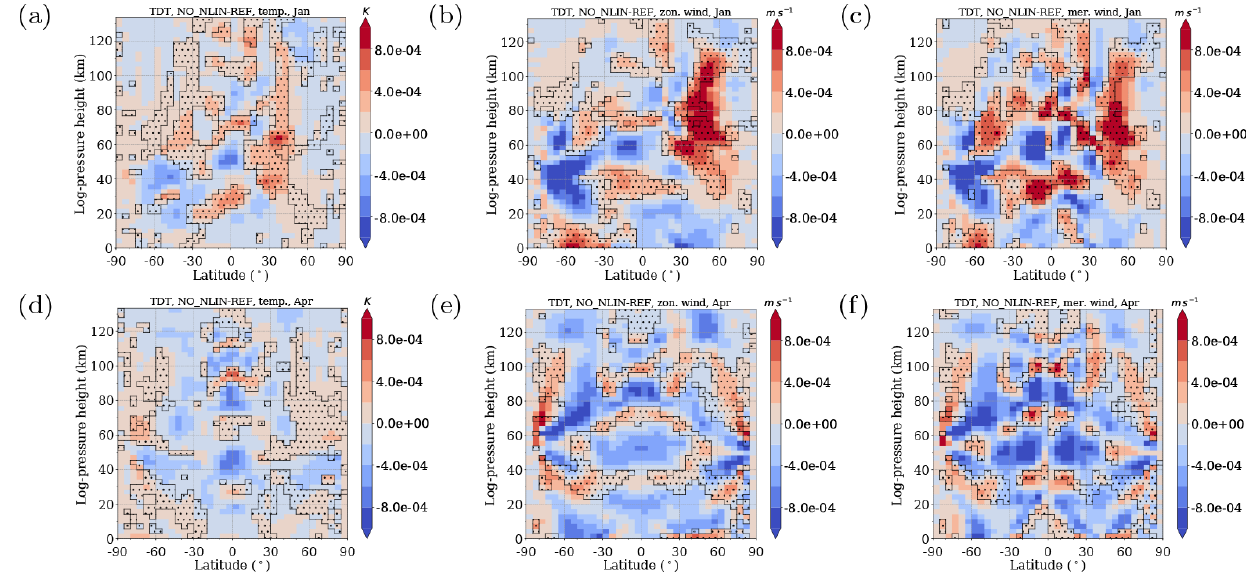
Figure 11. Difference of TDT amplitudes between NO_NLIN and REF simulation, scaled by exp {− z( 2 H) − 1 } . Red colors denote larger NO_NLIN simulation amplitudes and blue colors denote larger REF simulation amplitudes. Areas of destructive interferences (120 ◦ ≤ (cid:49)(cid:56) ≤ 240 ◦ ) between NO_NLIN and NO_SOL phases are hatched. (a, d) Temperature, (b, e) zonal wind, (c, f) meridional wind. (a–c) Solstice (January) conditions. (d–f) Equinox (April)